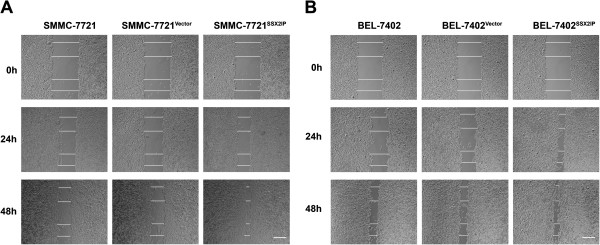
SSX2IP enhances scratch wound healing ability of hepatocellular carcinoma cells. A. Movement ability of SMMC-7721, SMMC-7721Vector and SMMC-7721SSX2IP cell lines was detected by scratch wound healing assays. B. Movement ability of BEL-7402, BEL-7402Vector and BEL-7402SSX2IP cell lines was detected by scratch wound healing assays. By wound distance analysis, the movement ability of HCC cells was enhanced by SSX2IP.